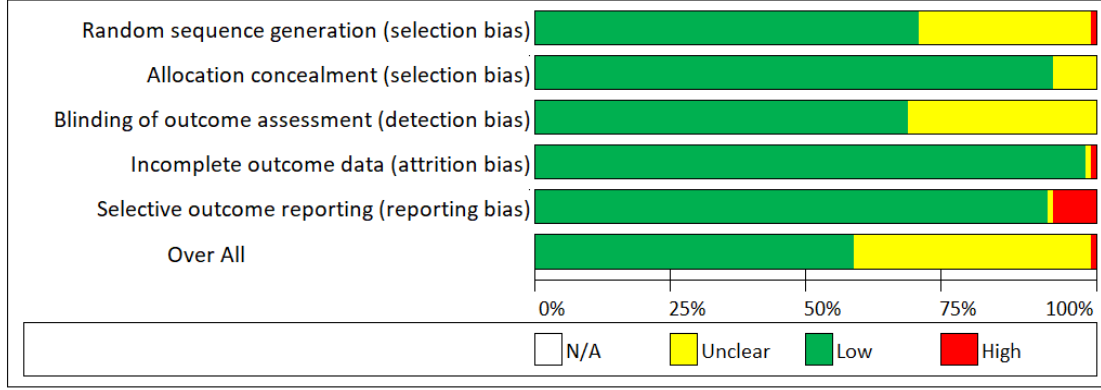
Figure 6. Risk of bias summary.